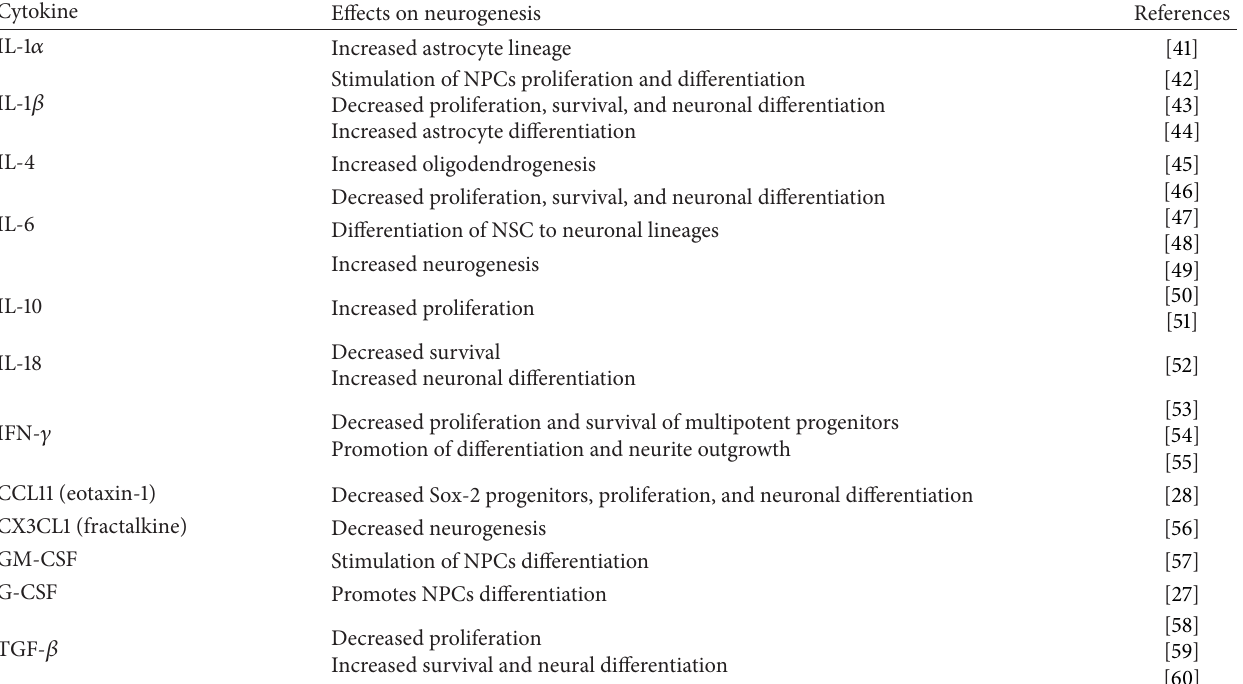
Table 1: Effects of different cytokines on